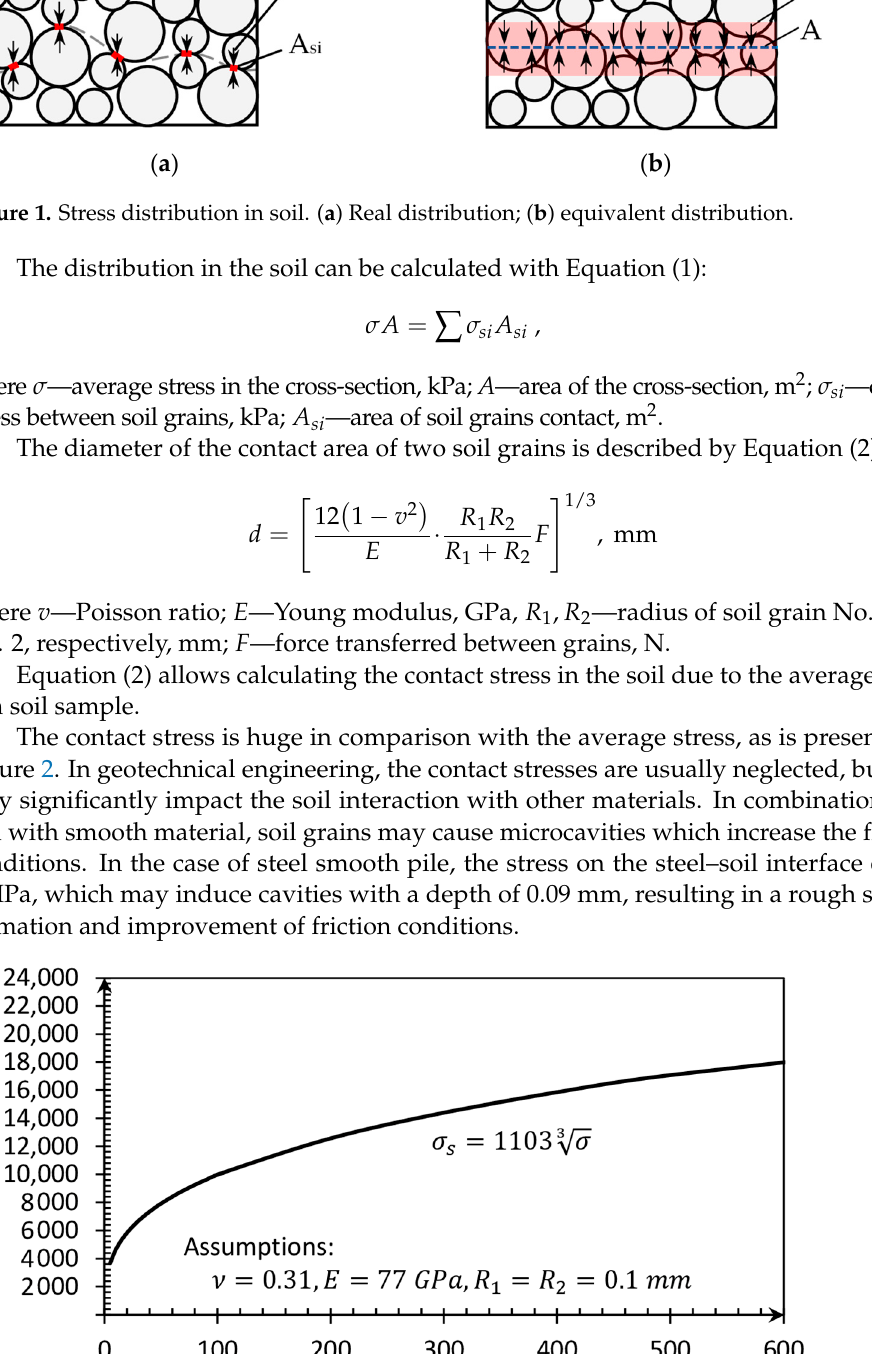
Figure 2. Contact stresses in soil grains versus average stress in a soil sample.